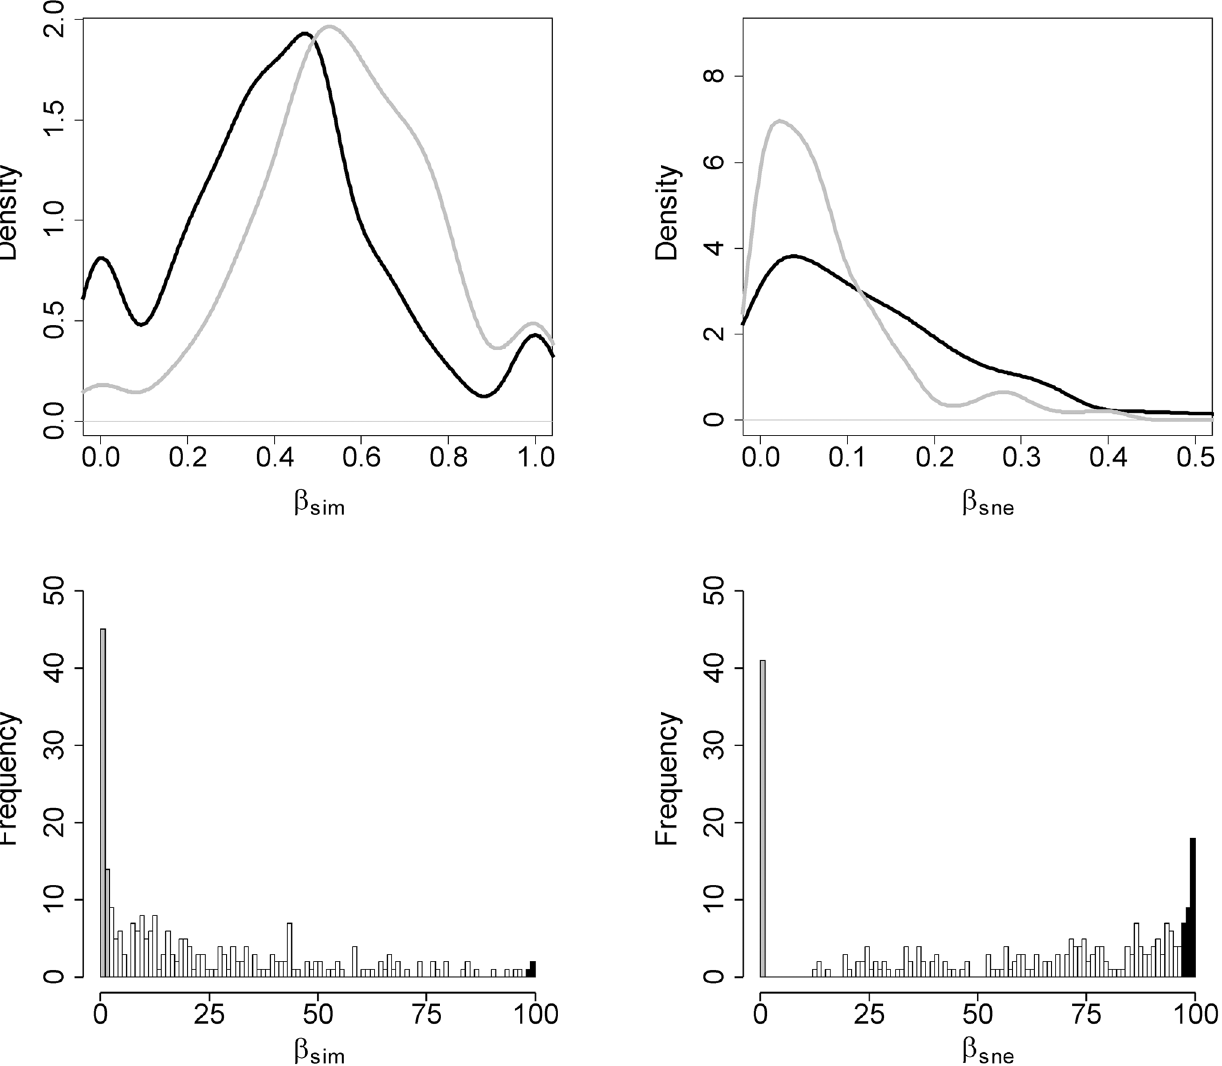
Fig 3. Observed patterns of temporal beta diversity against null expectations. (a) and (b) show the comparison between the distribution of observed temporal dissimilarities (1982 vs. 2007, black) and the distribution of null temporal dissimilarities (1982 vs. null assemblages, gray), for the turnover ( β sim ) and nestedness-resultant ( β sne ) components, respectively. (c) and (d) show the frequency distribution of sites for which the observed temporal turnover is significantly lower (gray) or higher (black) than the null expectation (random reshuffling of the regional pool fixing species